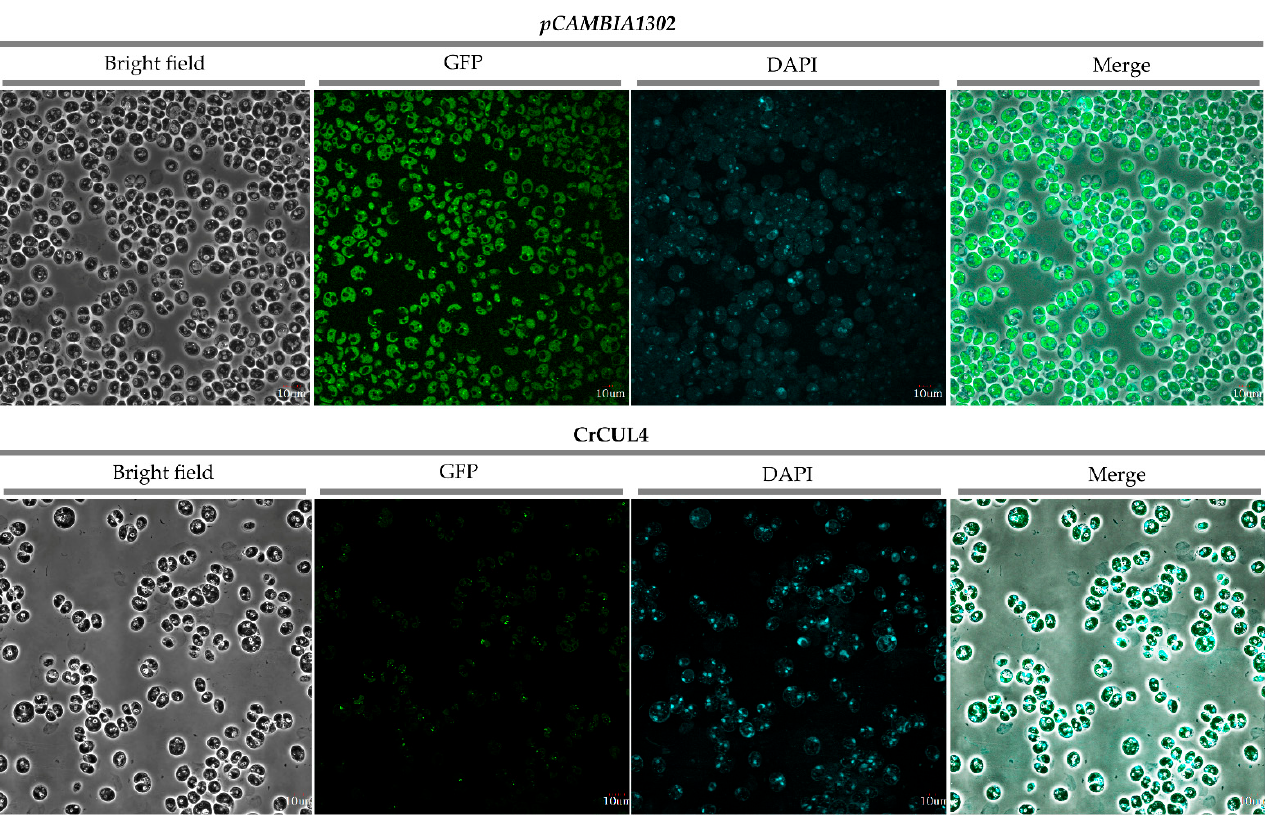
Figure 6. Localization of the CrCUL4-GFP protein. Individual panels show corresponding bright-field images, CrCUL4-GFP in C. reinhardtii CC124 cells and DAPI stained images and merged images, respectively. CrCUL4-GFP fusion was driven by the CaMV 35S promoter in vector p CAMBIA1302 .Bars = 10 µm.